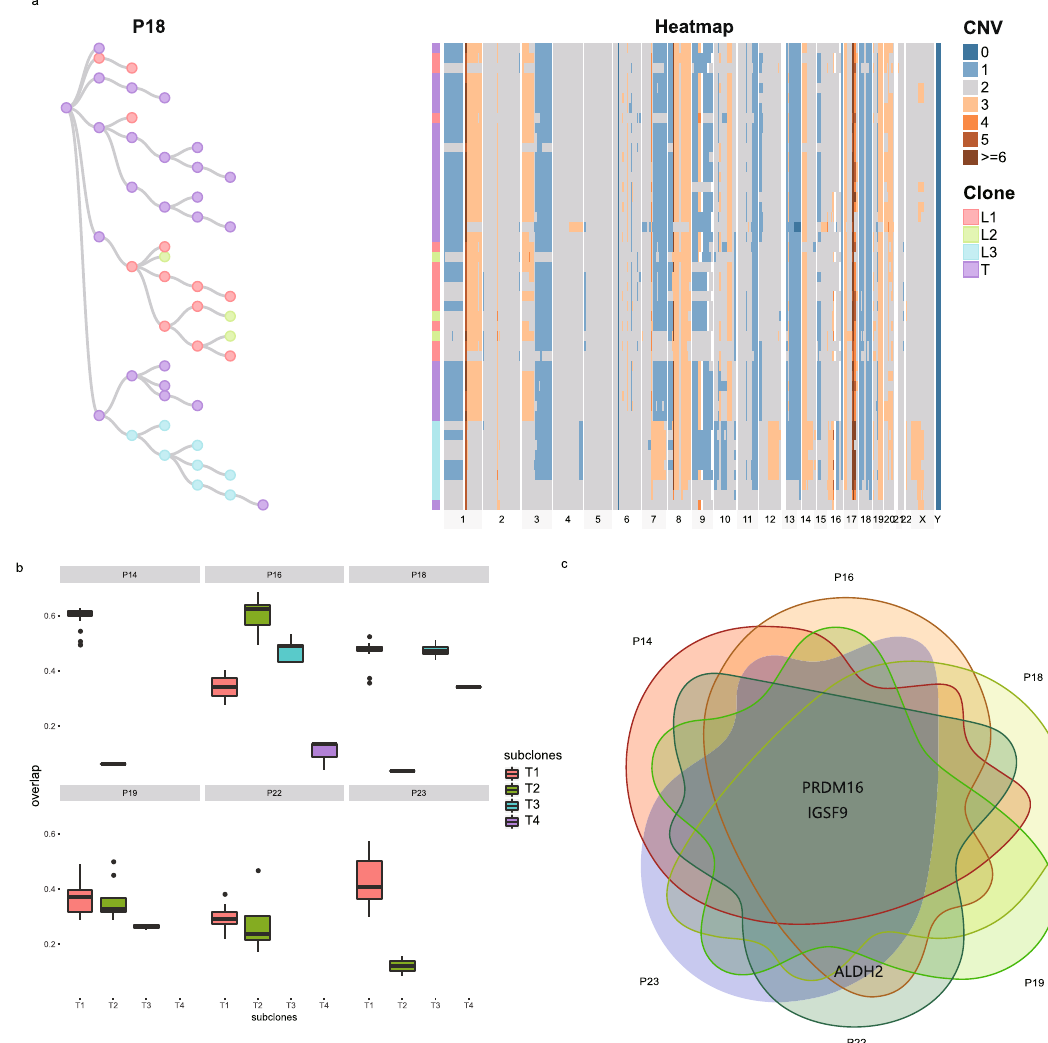
Fig. 6 Copy-number evolution of single-cell clusters from primary IMPC to metastatic lymph nodes in six samples. a IMPC single-cell cluster phylogenetic tree of patient P18. Heatmap depicting the genome-wide CNVs (columns) across single-cell clusters (rows). Copy-number gains and losses are encoded by red and blue color gradients, respectively. Tree illustrating the evolutionary relationship based on the minimum spanning tree method. Colored annotations indicate the clonal membership of the cell clusters, showing that multiple lymphatic metastases originated from the same primary subclone. b The overlap among the CNV genes in each clone in the primary tumor and lymph node metastases of six patients with IMPC. Boxplots illustrate the degree of similarity between the primary subclone and the metastatic foci at the CNV level in each sample (with the box plot center, box, whiskers, and points corresponding to the median, interquartile range, 1.5× interquartile range, and outliers, respectively). The higher the similarity, the more likely the subclone is to metastasize to lymph nodes; thus, the corresponding single-cell clusters of the subclone have a higher chance of metastasis. The horizontal axis shows the subclone numbers as represented by different colors. The vertical axis shows the similarity rate. c Common characteristics of CNVs in subclones selected from b . Scaled Venn diagrams re fl ecting the overlap among subclones from 6 samples with each number representing a CNV shared by two or more subclones; the genes are high-frequency recurrent CNV events among the 6 patients with IMPC, including the loss of IGSF9 and PRDM16 and gain of ALDH2 drivers of high lymph node metastasis in patients with IMPC (Fig. 6c). These fi ndings are consistent with the hypothesis that several genes can collectively promote lymph node metastasis when they contain gain or loss CNVs in primary tumors. We randomly selected 86 FFPE IMPC tissues for the three genes are associated with lymph node metastasis in patients with IMPC. The samples were divided into low- and high-